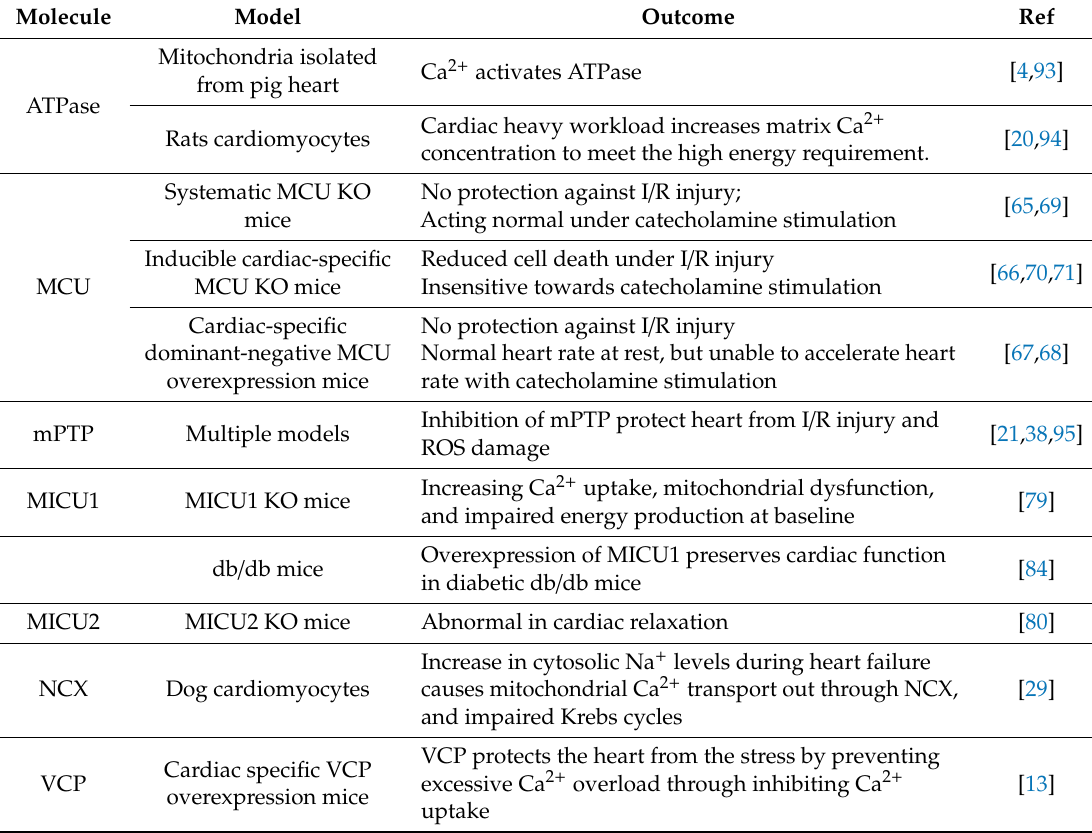
Table 1. Summary of mitochondrial Ca2 + uptake studies related to cardiac